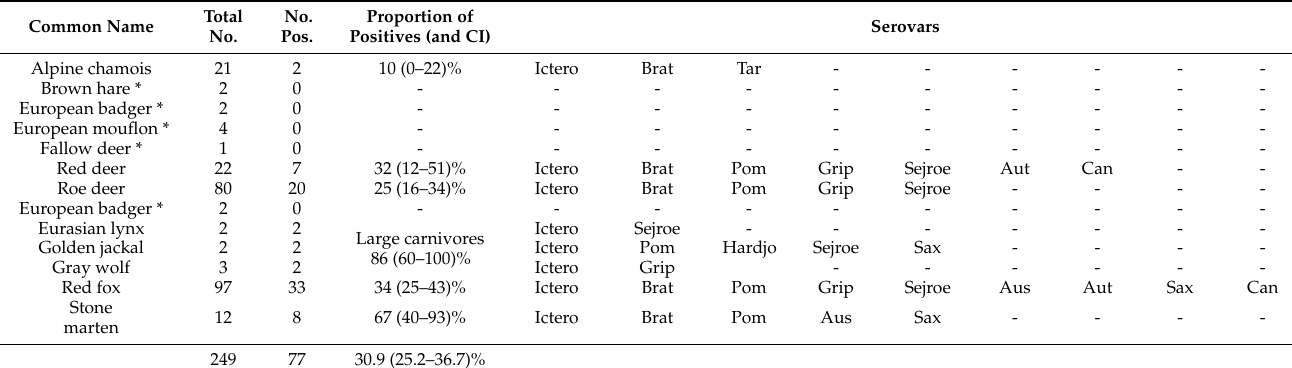
* The proportion and CI of positive samples are not presented due to unreliability resulting from small sample size. Abbreviations: Icterohaemorrhagiae (Ictero), Bratislava (Brat), Pomona (Pom), Grippotyphosa (Grip), Australis (Aus), Autumnalis (Aut), Canicola (Can), Saxkoebing (Sax) and Tarassovi